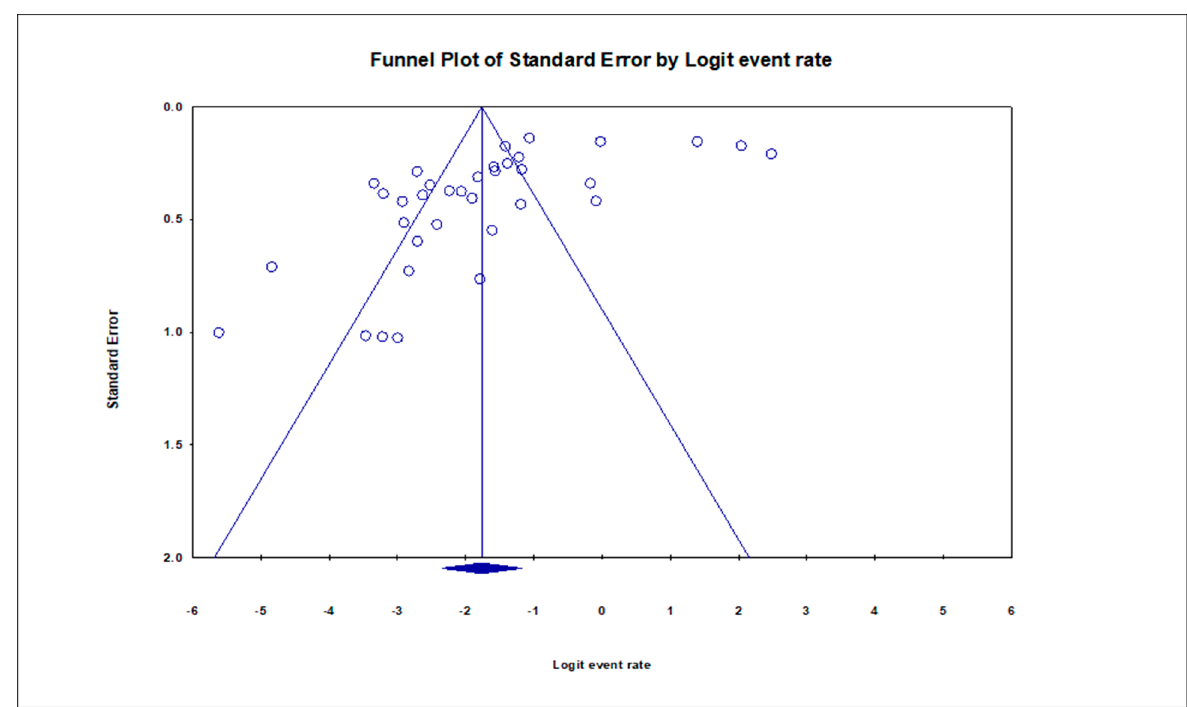
Figure 3. Funnel plot showing publication bias in studies reporting the prevalence of VRE in companion animals.